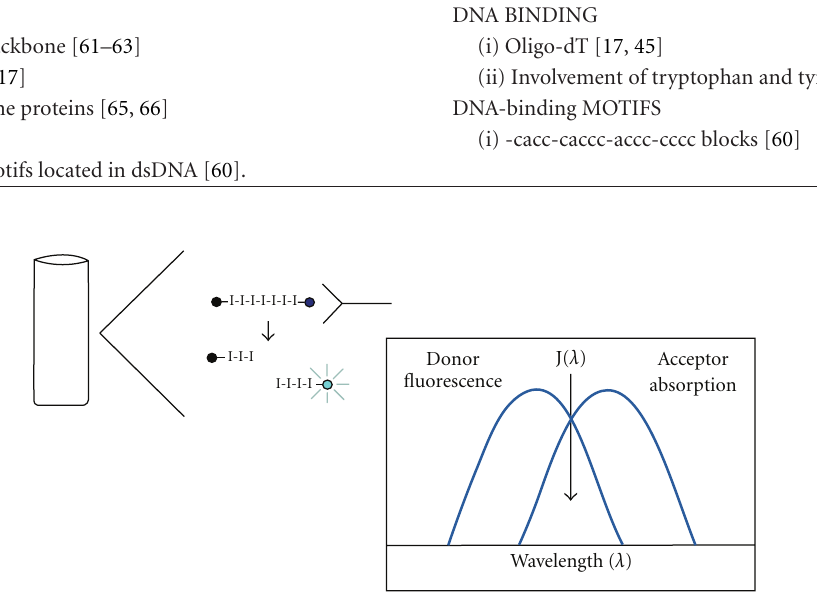
Figure 6: Continuous fluorescence-based hydrolysis assay.